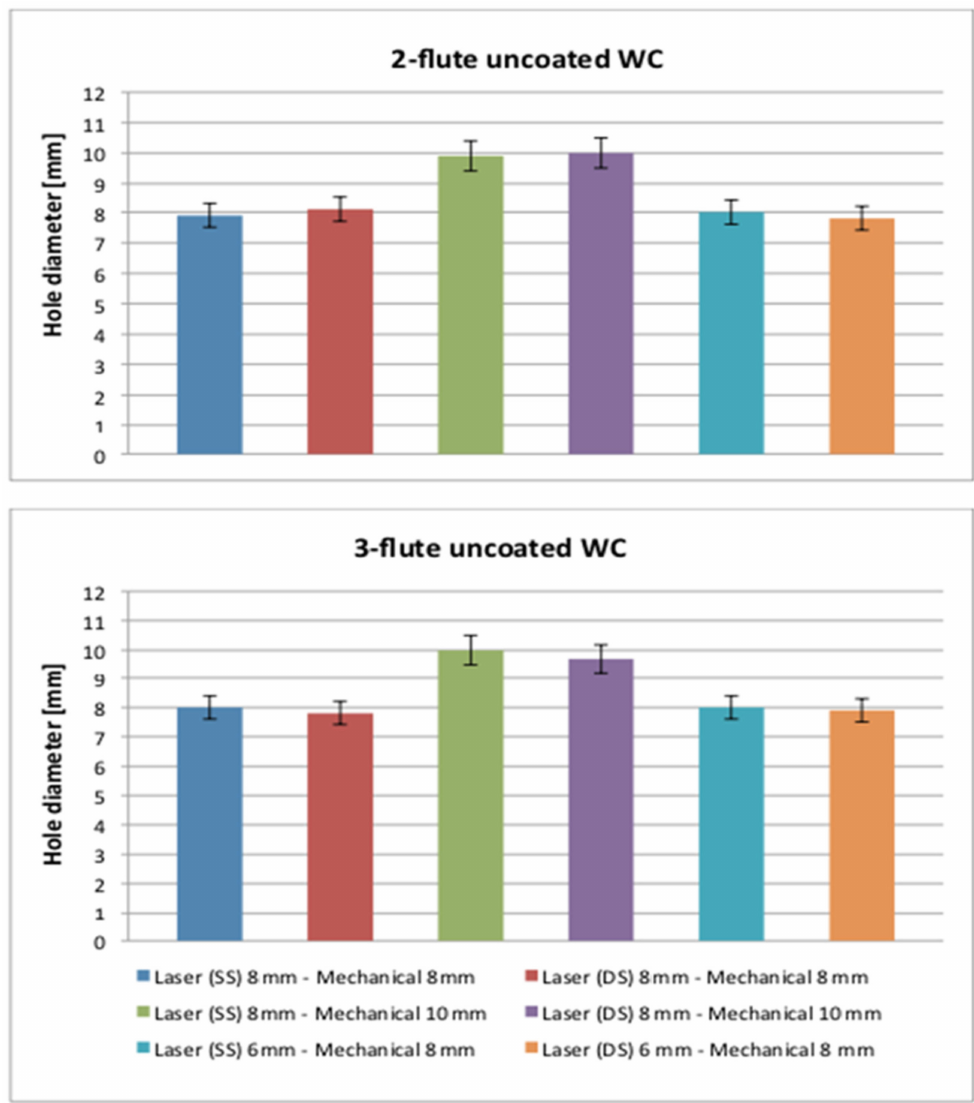
Figure 11. The results of the hole diameters resulting from sequential drilling. When the softening of the resin became excessive due to the heat generated by the laser beam, the fibre spring back was significantly apparent after the second step of sequential drilling, as can be seen in Figures 5 and 12. Figure 12a shows the HAZ, as well as the possibility that delamination and fibre spring back occurred for sequential drilling, which was adversely affected since some of the fibres were deflected during cutting and sprung back when the tool was retracted. Figure 12b shows a typical example of the hole edge quality contributing to machining induced surface debris due to an inefficient